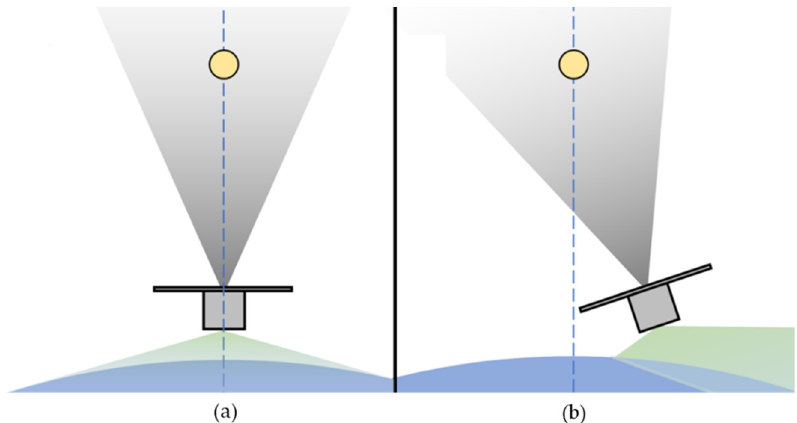
Figure 7. ( a ) The satellite alignment for a noon crossing orbit. The direction of satellite travel is on the page. ( b ) Simulation of the effect of a 15° tilt required to maintain solar alignment for an SSO one hour offset from noon. The dashed line represents local noon, the green beam is indicative of the effect on a secondary antenna.